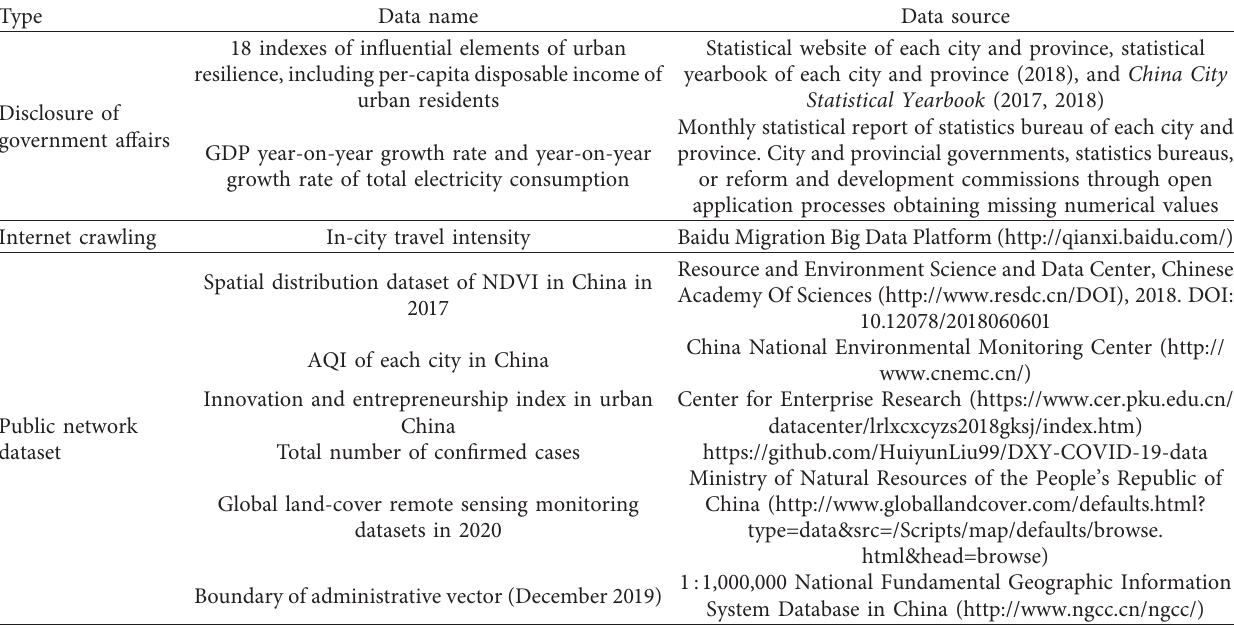
Table 3: Data sources.